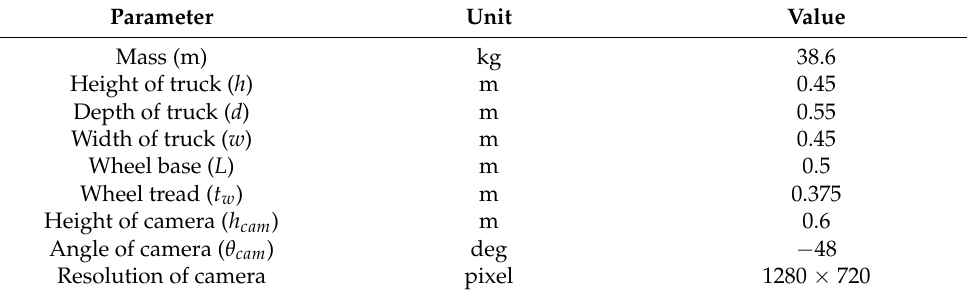
Table 1. Autonomous truck and camera specifications.